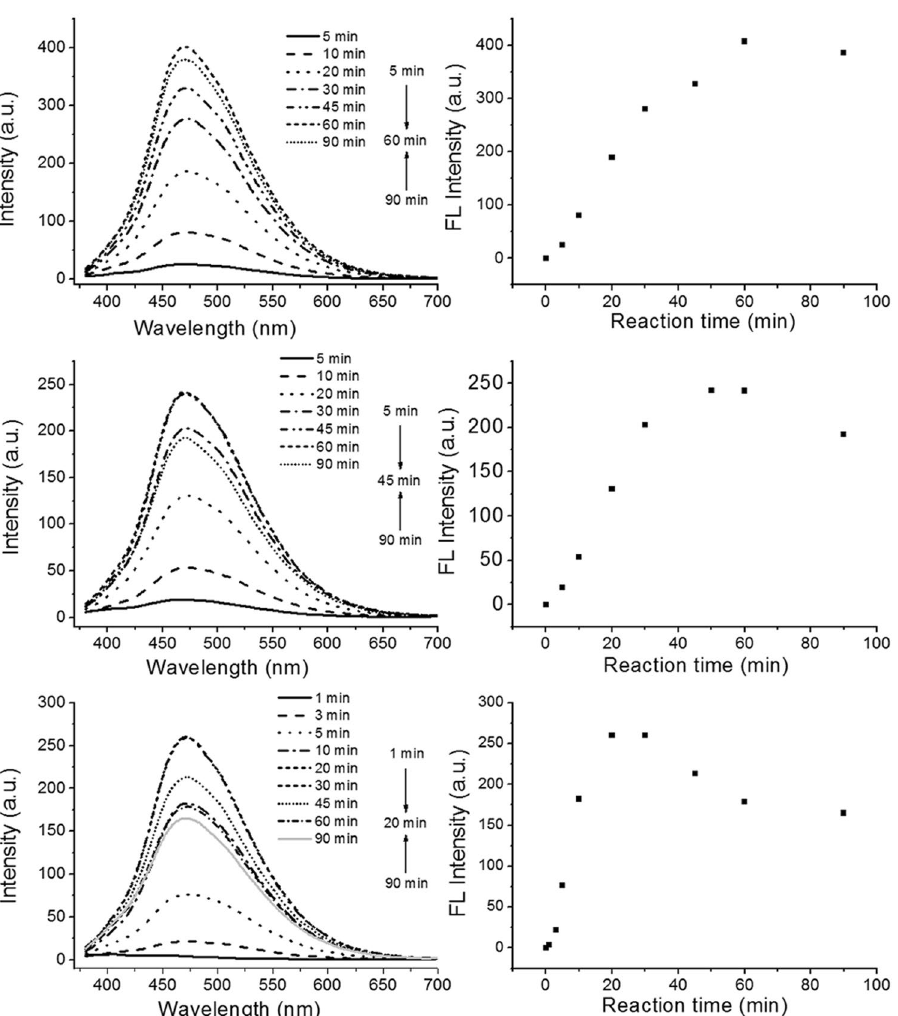
Figure 2. The photoluminescence emission spectra of N-dots produced at different UV-irradiation intensities: ( a ) 20, ( b ) 30, and ( c ) 50 mW/cm 2